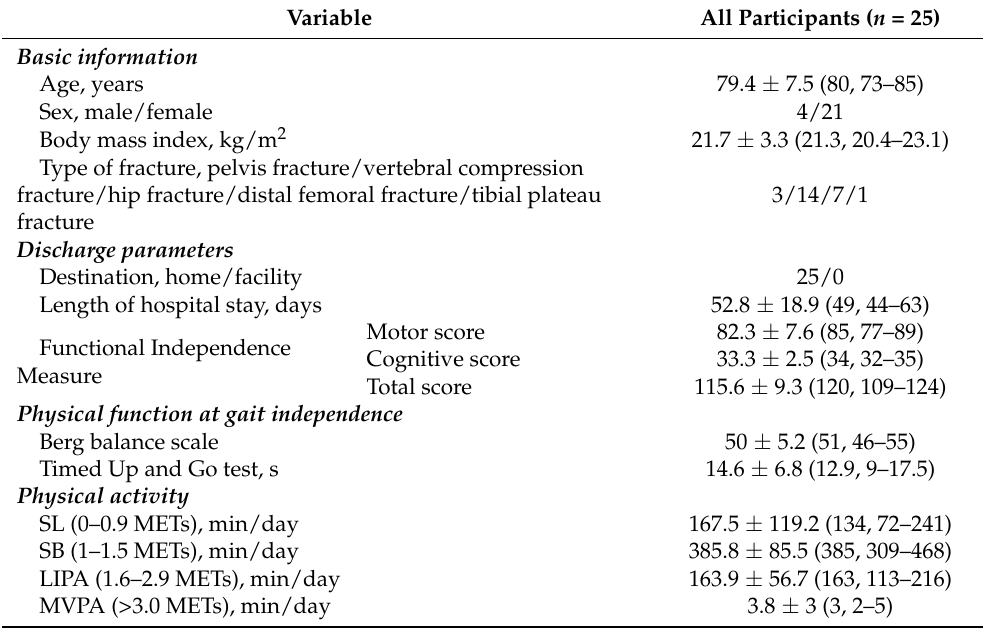
Table 1. Basic information, discharge parameters, physical function, physical activity for all partici-